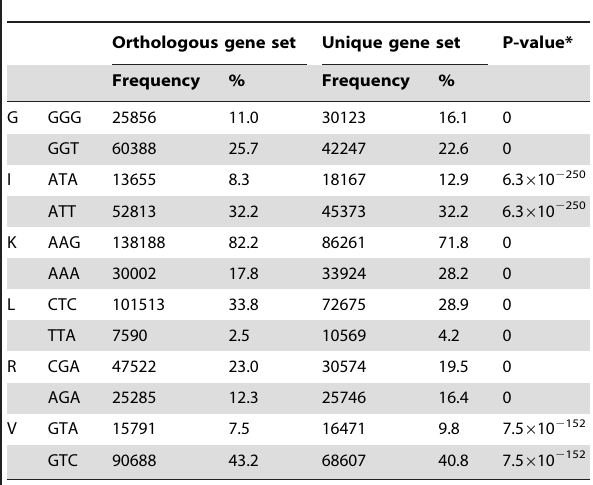
Figure 5. G + C content of orthologs, possible pseudoparalogs, and unique genes. Table 1. Differences in codon usage between orthologs and unique genes in N. haematococca MPVI.